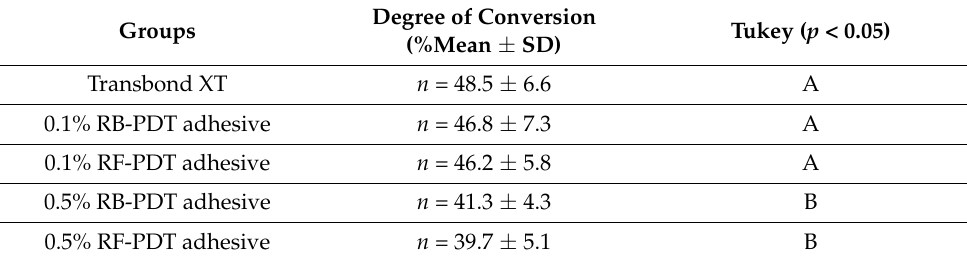
Table 1. Degree of conversion in percentage of all groups.